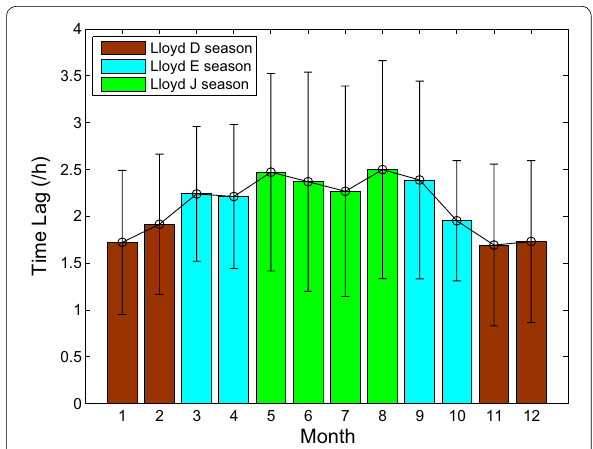
Fig. 4 The averages and standard deviations of the time lags aver- aged over all UT intervals from 2011–2013 in each month. The vertical bars represent the corresponding standard